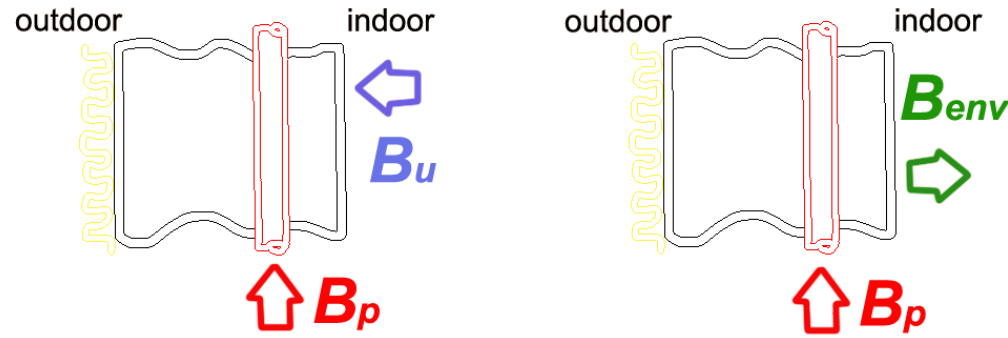
Figure 3. Envelope simplified fluxes: during the summer day, the useful effect B u is represented by the absorption of internal gains (on the left), whilst during the night, B env is released to the external air by means of increased ventilation (on the right). The power input B p , if needed, is delivered by the distribution system (here represented by the embedded red